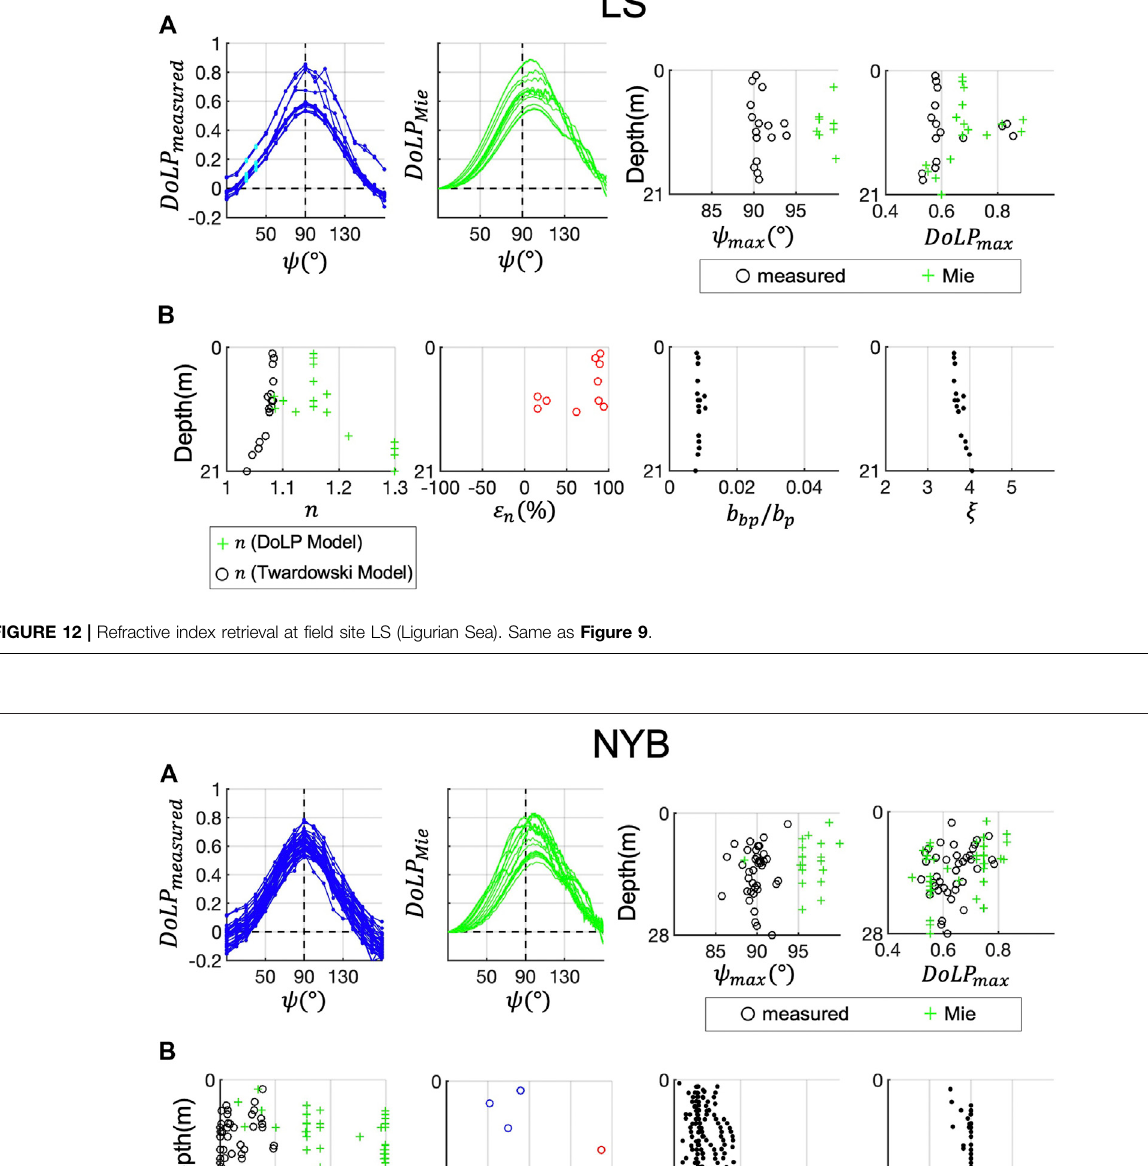
Frontiers in Remote Sensing |